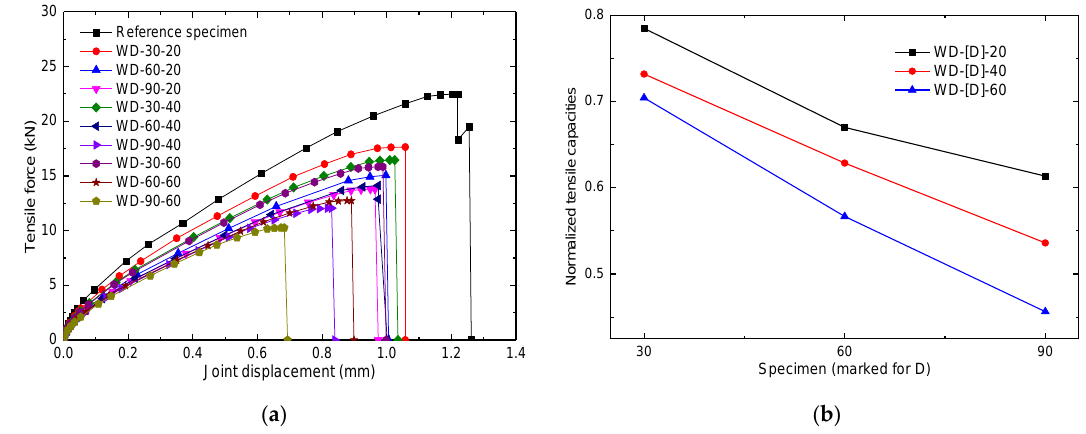
Figure 6. Specimens of wet–dry (WD) series. ( a ) Load–Displacement Curves; ( b ) Normalized Tensile Capacities.